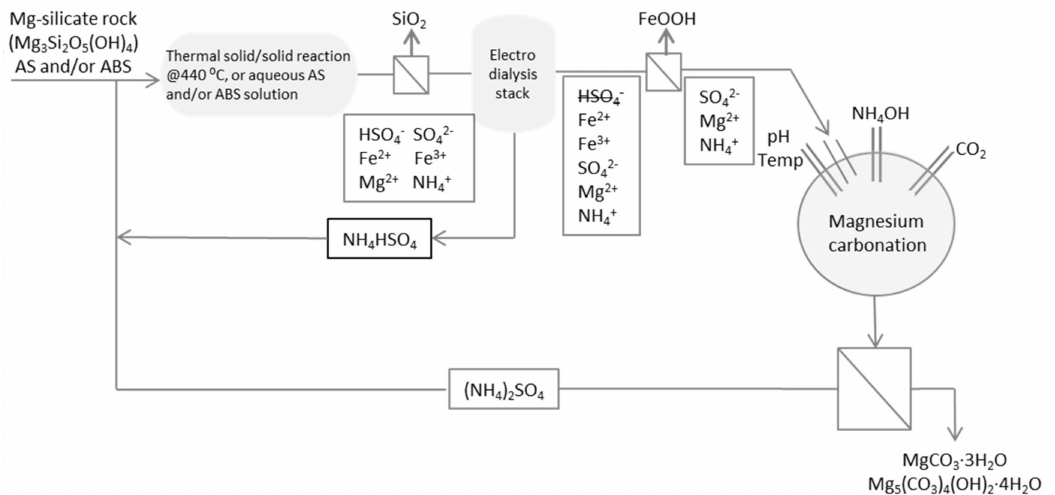
Figure 1. Principle scheme for the application of electrodialysis and separation by monovalent membranes to a mineral carbonation process. Thermal solid/solid reaction refers to the reaction at approximately 440 ◦ C of a mixture between Mg-silicate rock and ammonium sulfate (AS) and/or ammonium bisulfate (ABS)